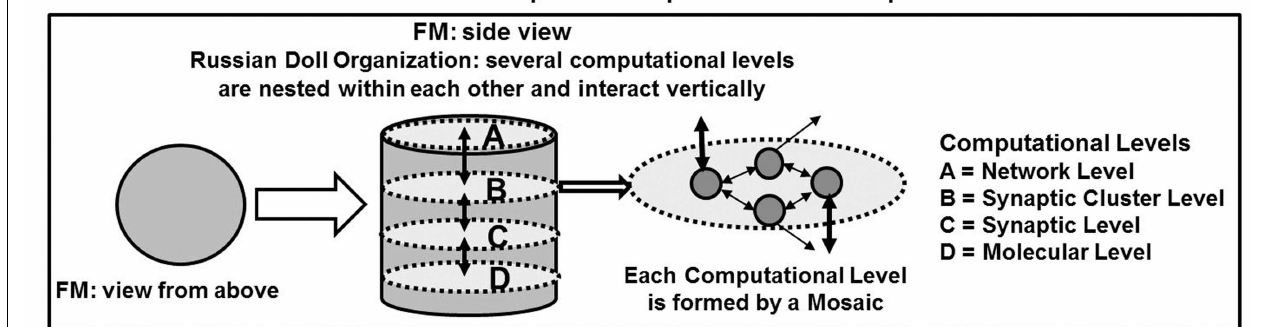
each FM is pointed out by remarking the horizontal elaboration that takes place within a hierarchic (miniaturization) level and the vertical elaboration that takes place among the various hierarchic (miniaturization)